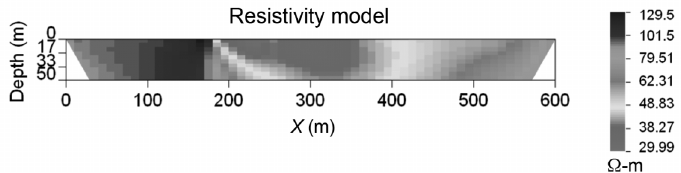
Fig. 18. Result of geophysical inversion, pdL configuration, Model 3, at 300 days: recovered